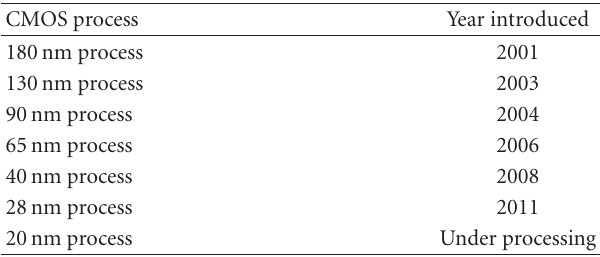
Table 2: Development of miniaturization